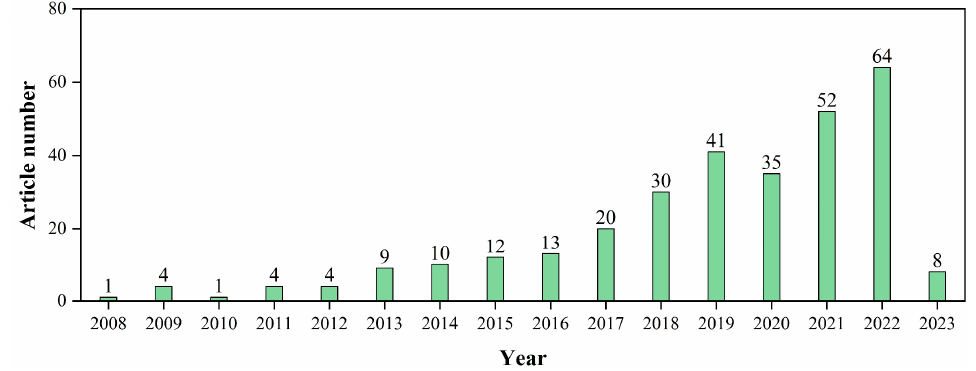
Figure 2. The development of biohydrogen production from S. japonica during the past years based on the number of articles being published until February 2023. The article number is determined by searching the Scopus database for “Article title, Abstract, Keywords” with the keyword as